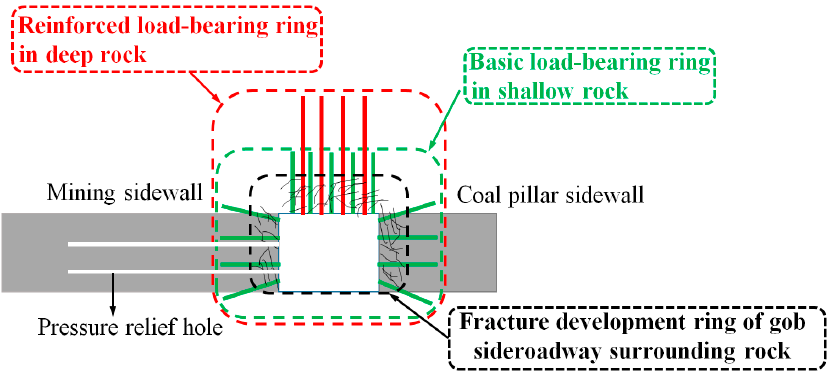
Figure 6. Collaborative control technology of pressure relief and anchorage.